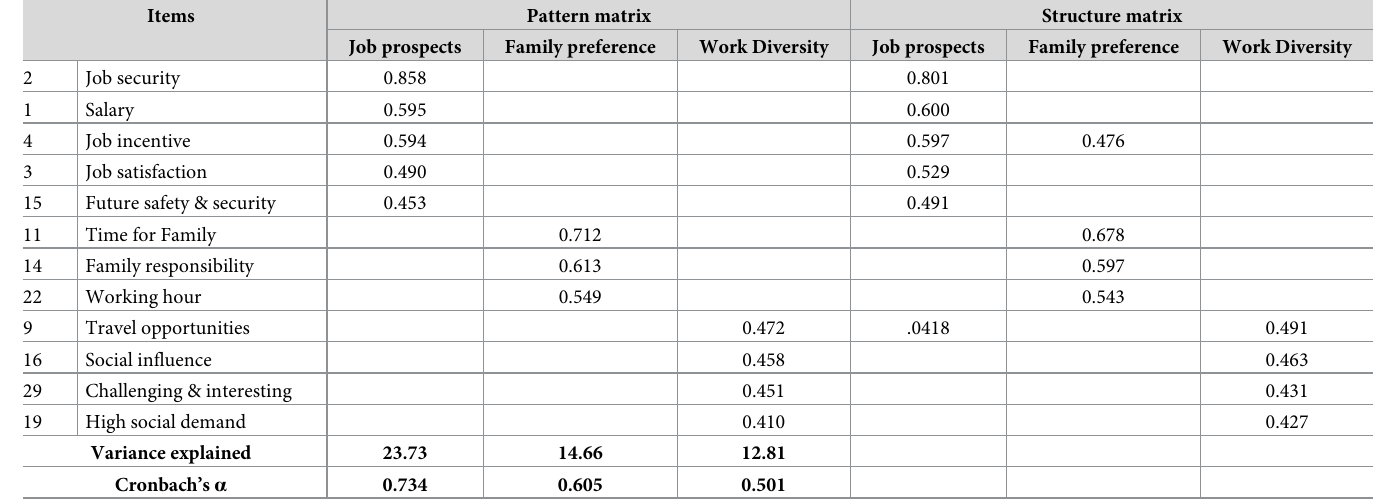
Table 2. Exploratory factor analysis (N =